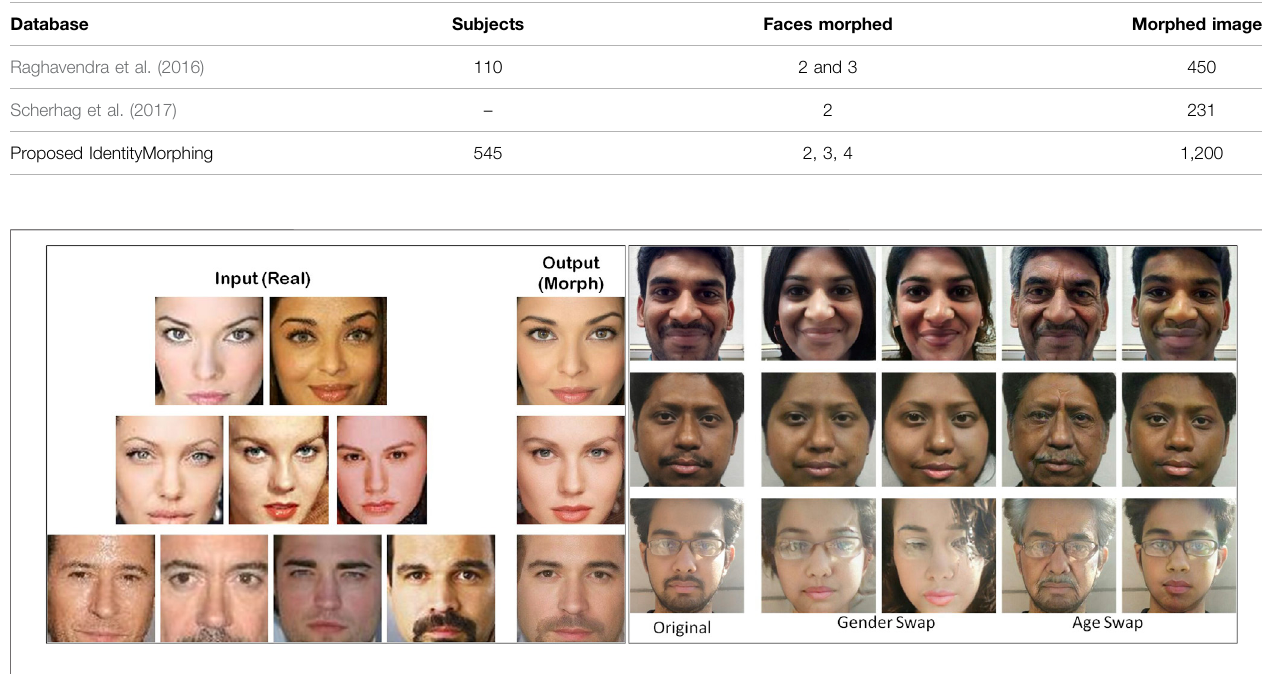
TABLE 1 | Characteristics of the proposed and existing morph databases related to this